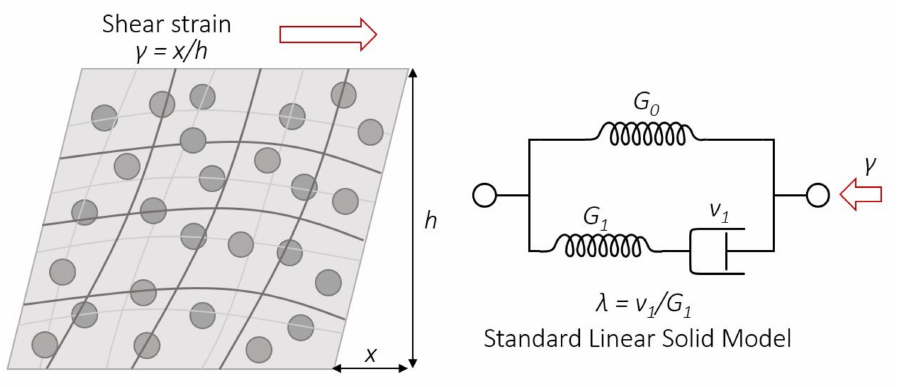
Figure 10. PDMS-MPs composite structure upon deformation ( left ) and scheme of the standard linear solid model ( right ).